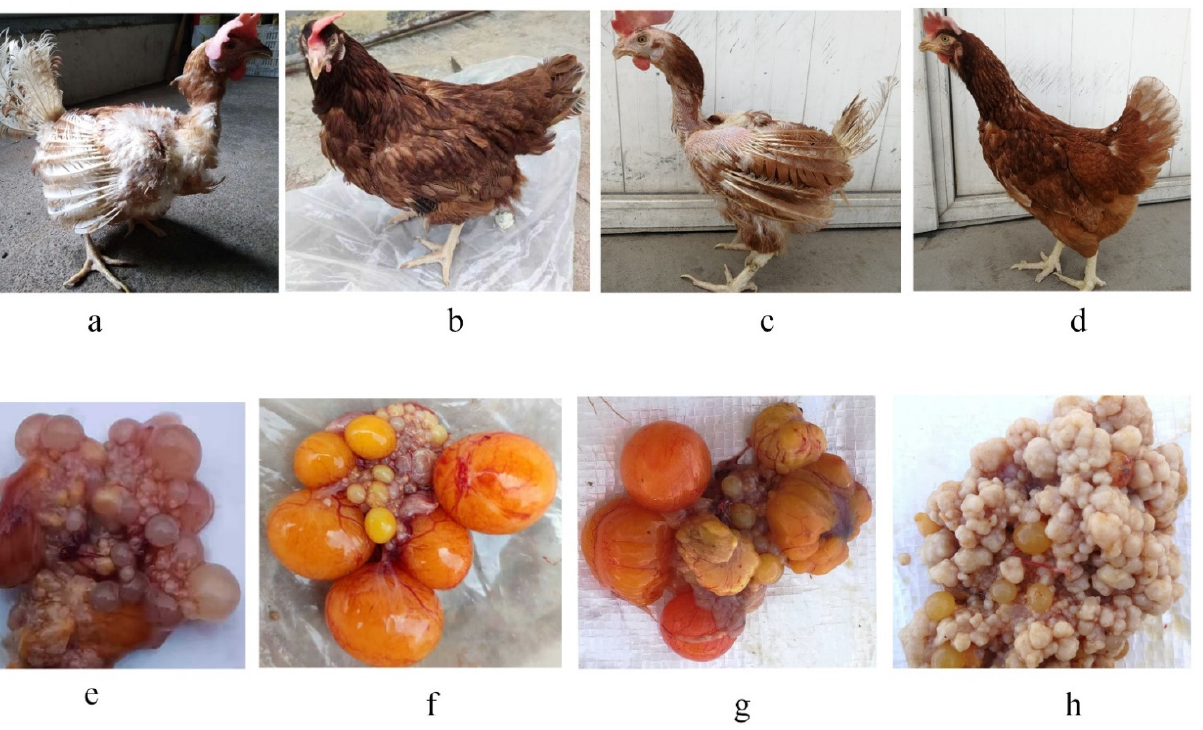
Figure 1. Feather coverage and corresponding ovarian tissue in forced molted and natural chickens for two different periods. A chicken that shed many feathers during the FM_1 period ( a ) and its corresponding ovarian tissue ( e ); A chicken with regrown feathers during the FM_2 period ( b ) and its corresponding ovarian tissue ( f ); A chicken that shed many feathers during the NM_1 period ( c ) and its corresponding ovarian tissue ( g ); A chicken with regrown feathers during the NM_2 period ( d ) and its corresponding ovarian tissue ( h ).